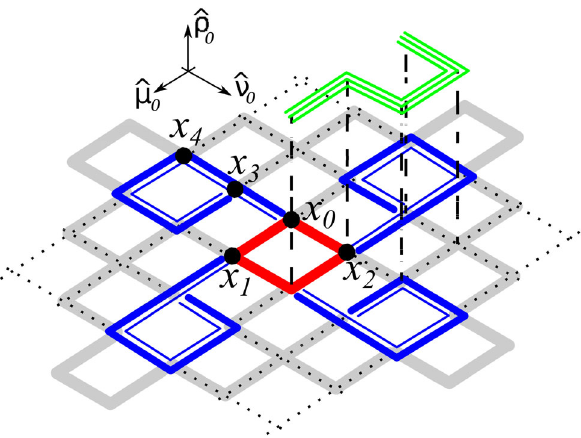
Fig. 2 A 3-dimensional representation of the lattice. For an update of ( x ) (solid red lines), the links represented the central plaquette U μ 0 0 ν 0 by red, blue (double lines) and green (triple lines) are integrated in the computation of the weight function ratio. In grey solid lines we shown a sample of the links that are rotated to the identity in the calculation of p . See text for